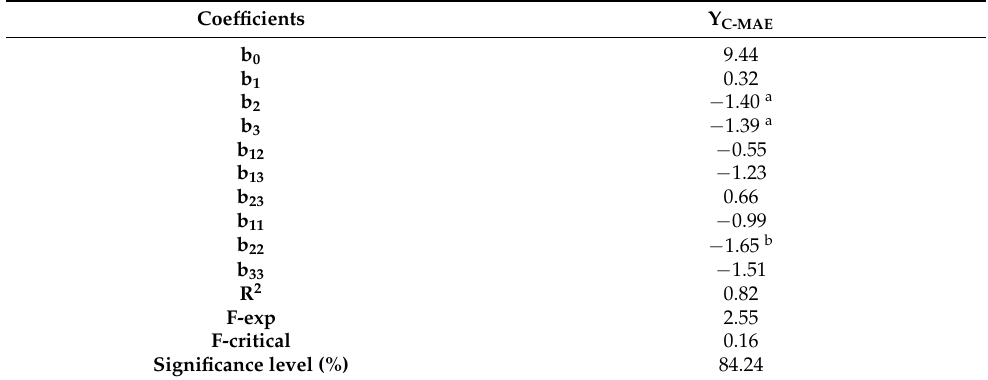
Table 2. Regression coefficients and statistical parameters of the optimization of Curcuma longa L. oil extraction by